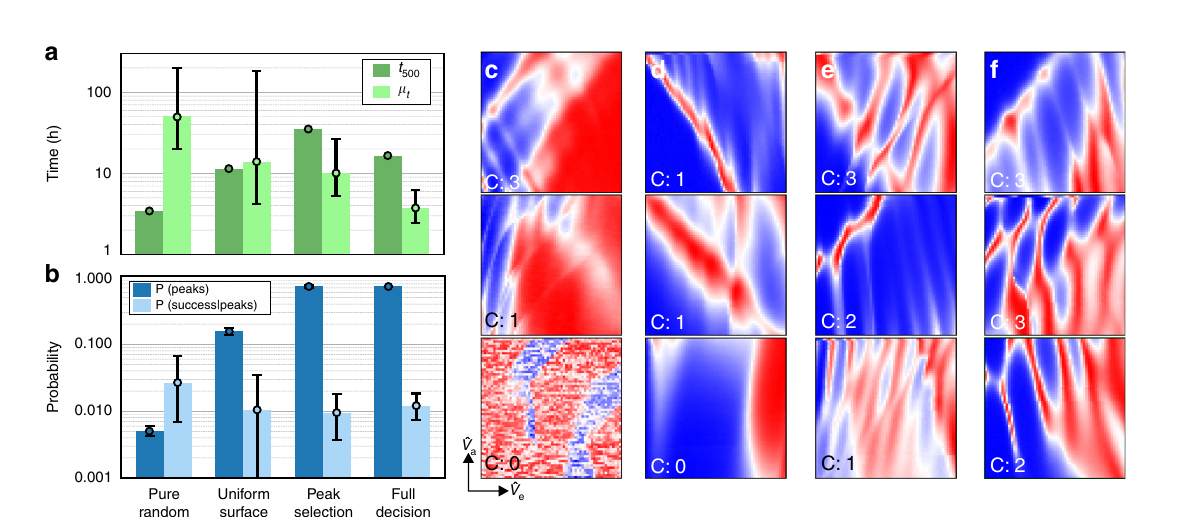
Fig. 6 Ablation study. a , b Bar charts and corresponding data points comparing μ t (light green), t 500 (dark green), P (peaks) (dark blue) and P (success ∣ peaks) (light blue) for the different algorithms considered. Error bars represent 80% (equal-tailed) credible intervals. Due to a measurement problem, 459 sampling iterations instead of 500 were considered for the Full decision algorithm. c – f High resolution current maps sampled by pure random, uniform surface, peak weighting, and full decision, respectively. In each panel, we indicate C , the number of human labellers that identi fi ed a map as displaying double quantum dot features. Current maps with identical values of C are displayed in the order in which they were sampled, from top to bottom. Current maps with C : 0 were randomly selected. Each panel uses an independent colour scale running from red (highest current measured) to blue (lowest current).